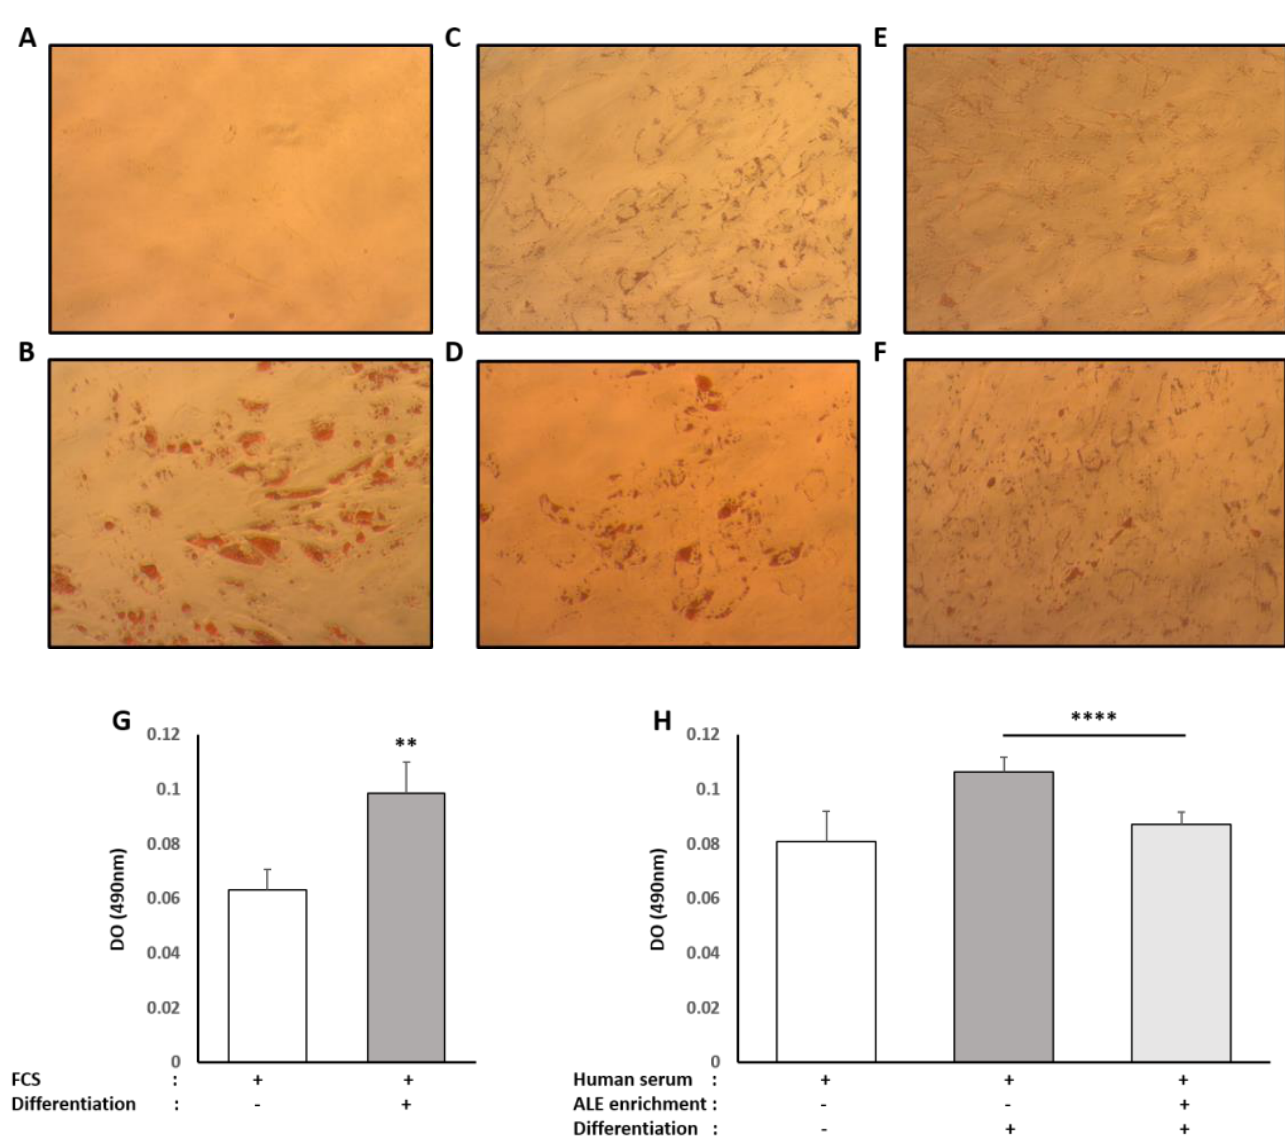
Figure 8. Effect of human serum enriched with ALE metabolites on total intracellular lipid content in primary human subcutaneous pre-adipocytes: Primary human subcutaneous pre-adipocytes were differentiated for 8 days in an adipocyte differentiation medium consisting of Preadipocyte Growth Medium-2, supplemented with insulin, dexamethasone, in- domethacin and isobutyl-methylxanthine. To analyze the effects of human serum enriched with metabolites, cells were either differentiated in the presence of fetal calf serum ( A , B ), human naive serum ( C , D ) or ALE enriched human serum ( E , F ). Intracellular lipid content was analyzed using a red oil coloration. After microscopical observation, the fixed dye was redissolved in 100% isopropanol, and optical density was measured at 490 nm in order to quantify lipidic content ( G , H ). Differentiation increases intracellular lipid content independently of the origin of the serum (calf or human). The human serum enriched with ALE metabolites significantly limited the intracellular lipid accumulation in differentiated